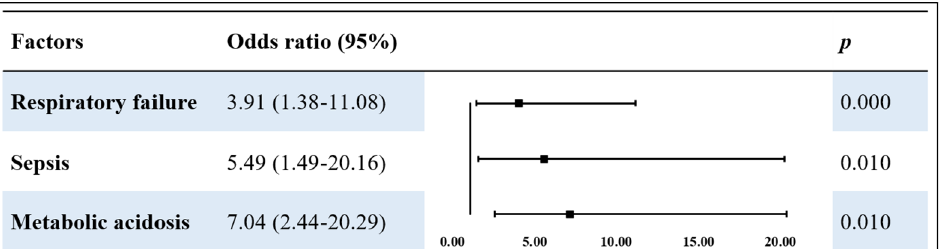
TABLE 6 Multivariable logistic analysis of risk factors of death in patients with